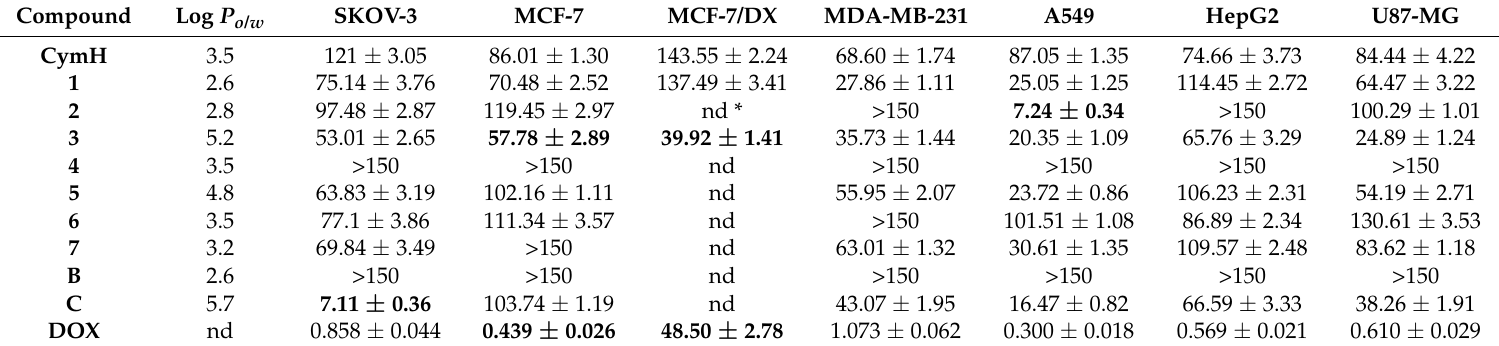
Table 1. Lipophilicity (log P o/w ) and cytotoxicity (IC 50 ; µ M) of compounds CymH , 1 – 7 , B , and C against human cancer cells a